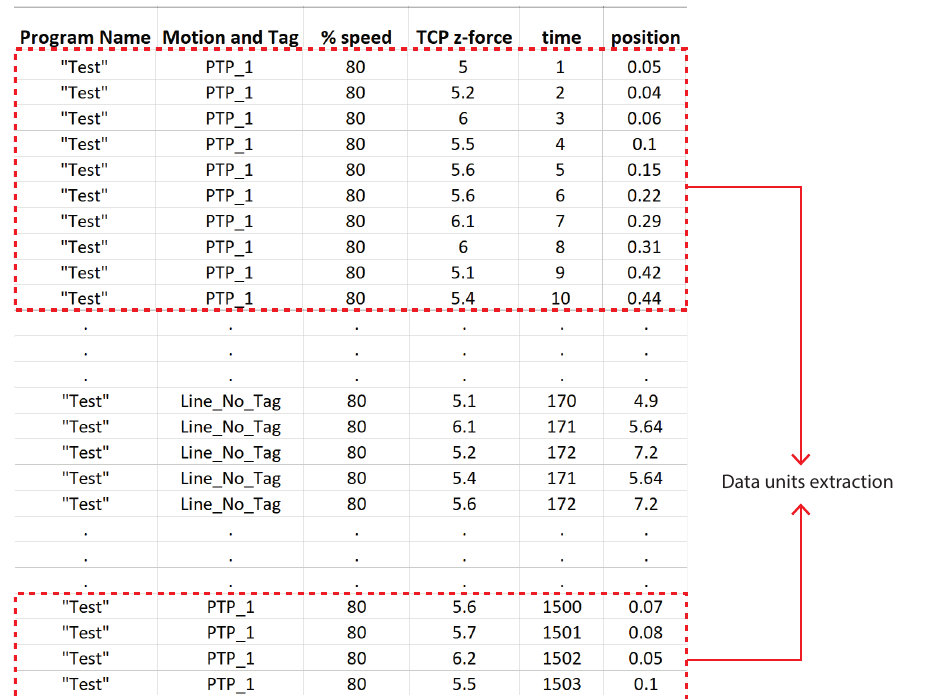
Figure 4. Example of data unit extraction referred to the program “Test” introduced in Section 3.3.